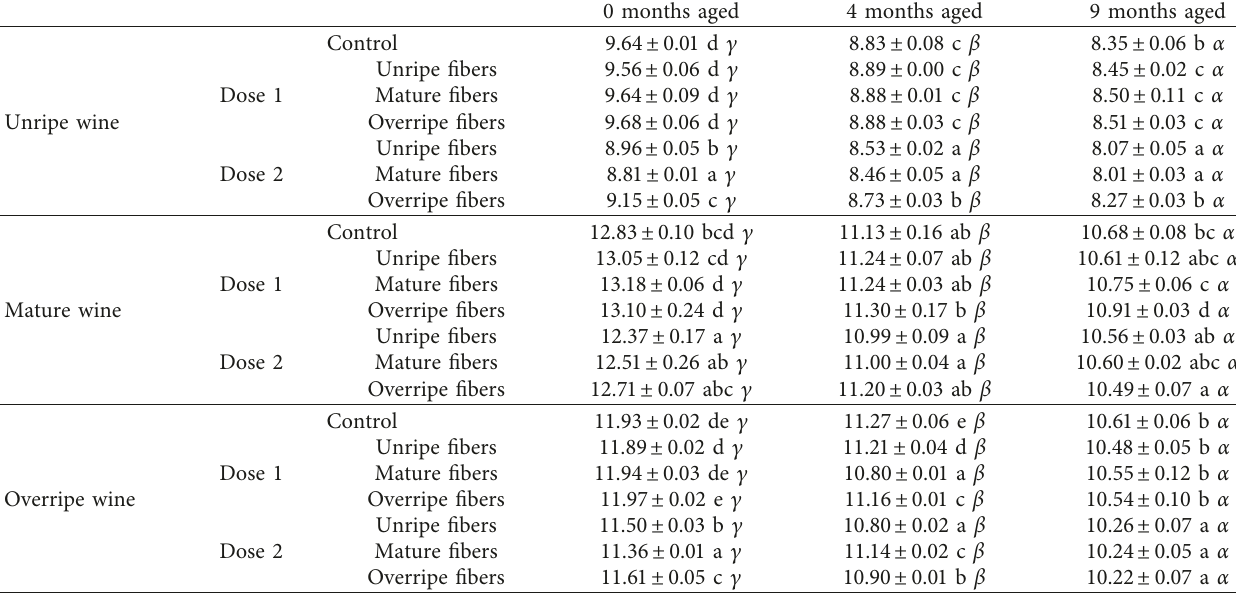
Table 4: Color intensity (CI) of the